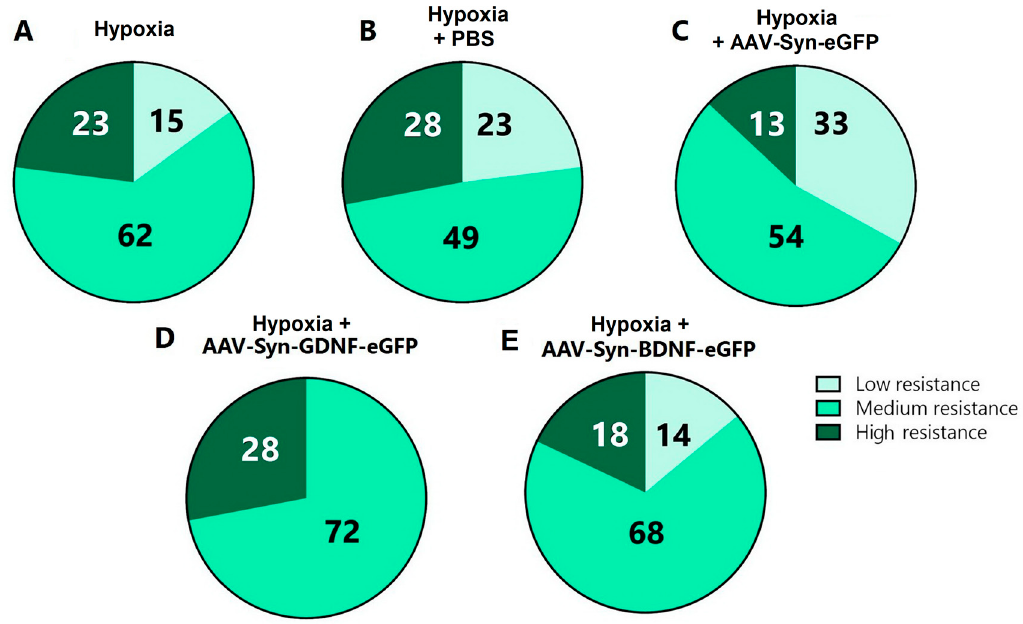
Figure 5. Distribution of animals according to the degree of resistance to acute hypobaric hypoxia, %. ( A )—“Hypoxia”; ( B )—“Hypoxia + PBS”; ( C )—“Hypoxia + AAV-Syn-eGFP; ( D )—“Hypoxia + AVV-Syn-GDNF-eGFP”; ( E )—“Hypoxia + AAV-Syn-GDNF-eGFP”. Animals with a survival time of less than 3 min were classified as low-resistant, from 3 to 7 min–as medium-resistant, and more than 7 min–as highly